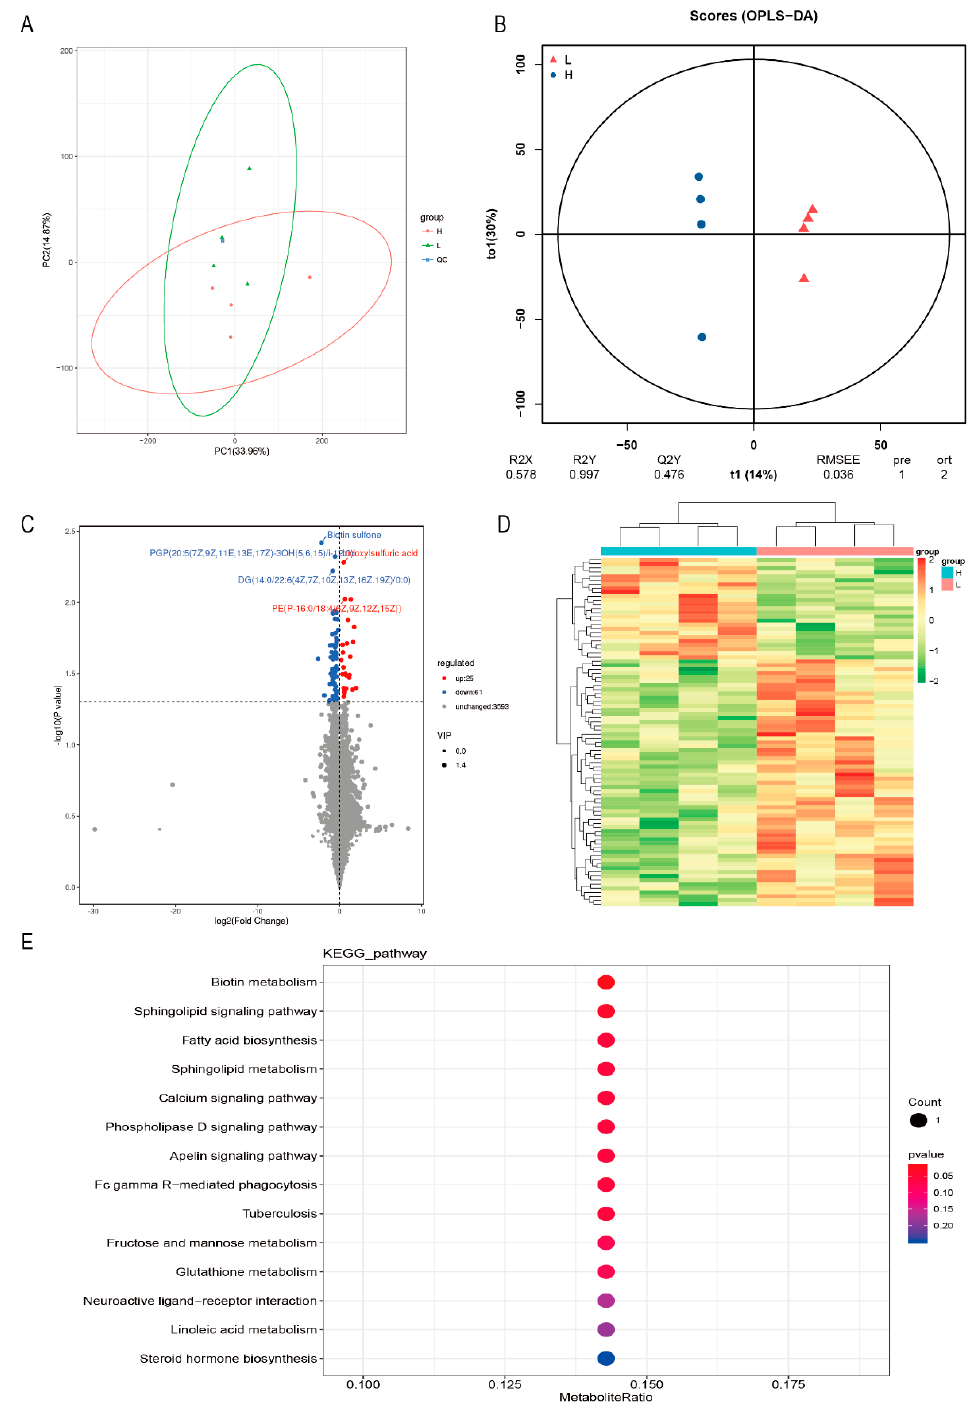
Figure 2. The separate metabolome data analysis of the BFT. ( A ) The principal component analysis (PCA). ( B ) The partial-least-squares-discriminant analysis (OPLS-DA) score plots. ( C ) The volcano plots of the DEMs. ( D ) The cluster heatmap of the DEMs. ( E ) The plot of the differential metabolite KEGG enrichment. The x -axis is the ratio of the number of DEMs in the corresponding pathway to the total number of metabolites that were detected and annotated in the pathway. The y -axis is the pathway name. The color of the dots represents the log ( p -value), with more red indicating a more signi fi cant enrichment. The size of the dots represents the number of di ff erentially enriched metab- olites.